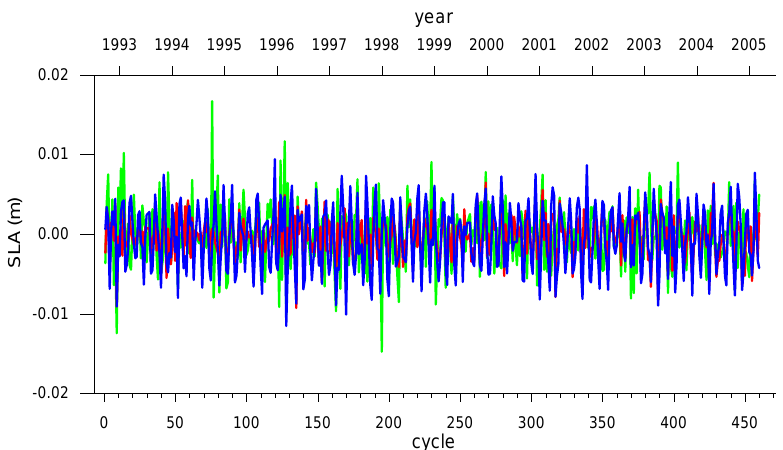
Figure 8b. SLA differences DataSet5-DataSet6 (different IB models: Variable Reference Pressure - combined_MOG2D) blue - Tropical; red : Sub-Tropical; green: Sub-Arctic.